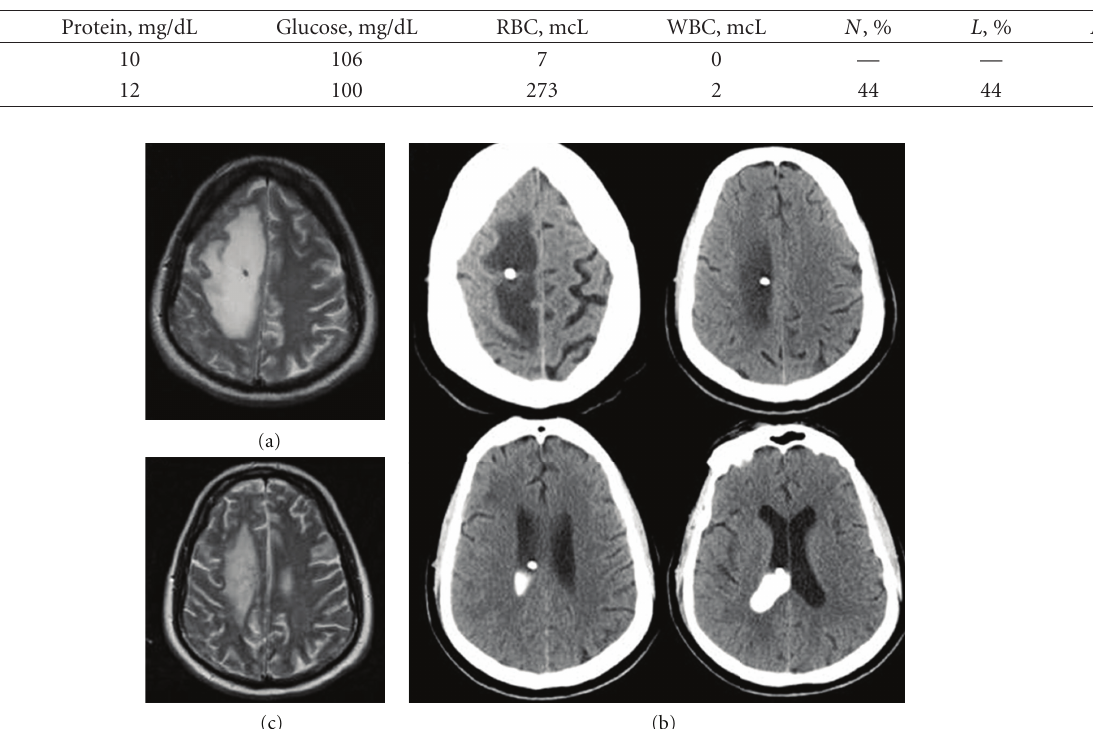
Table 1: Profile of the CSF withdrawn from the patients’ ventricular reservoirs.